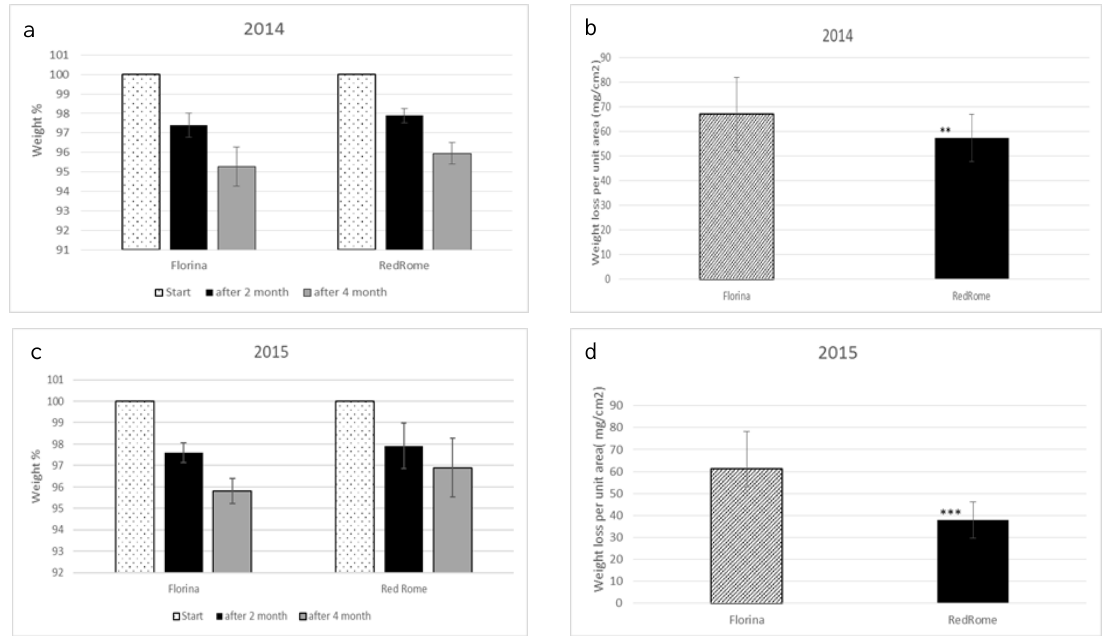
Figure 1. Comparison of relative weight loss (a, c) and weight loss per surface unit area (b, d) of ‘Florina’ and ‘Red Rome van Well’ fruits in 2014 and 2015. Vertical bars represent (SD). ** 0, 01<P; *** P<0,001 according to Student two tails t test.